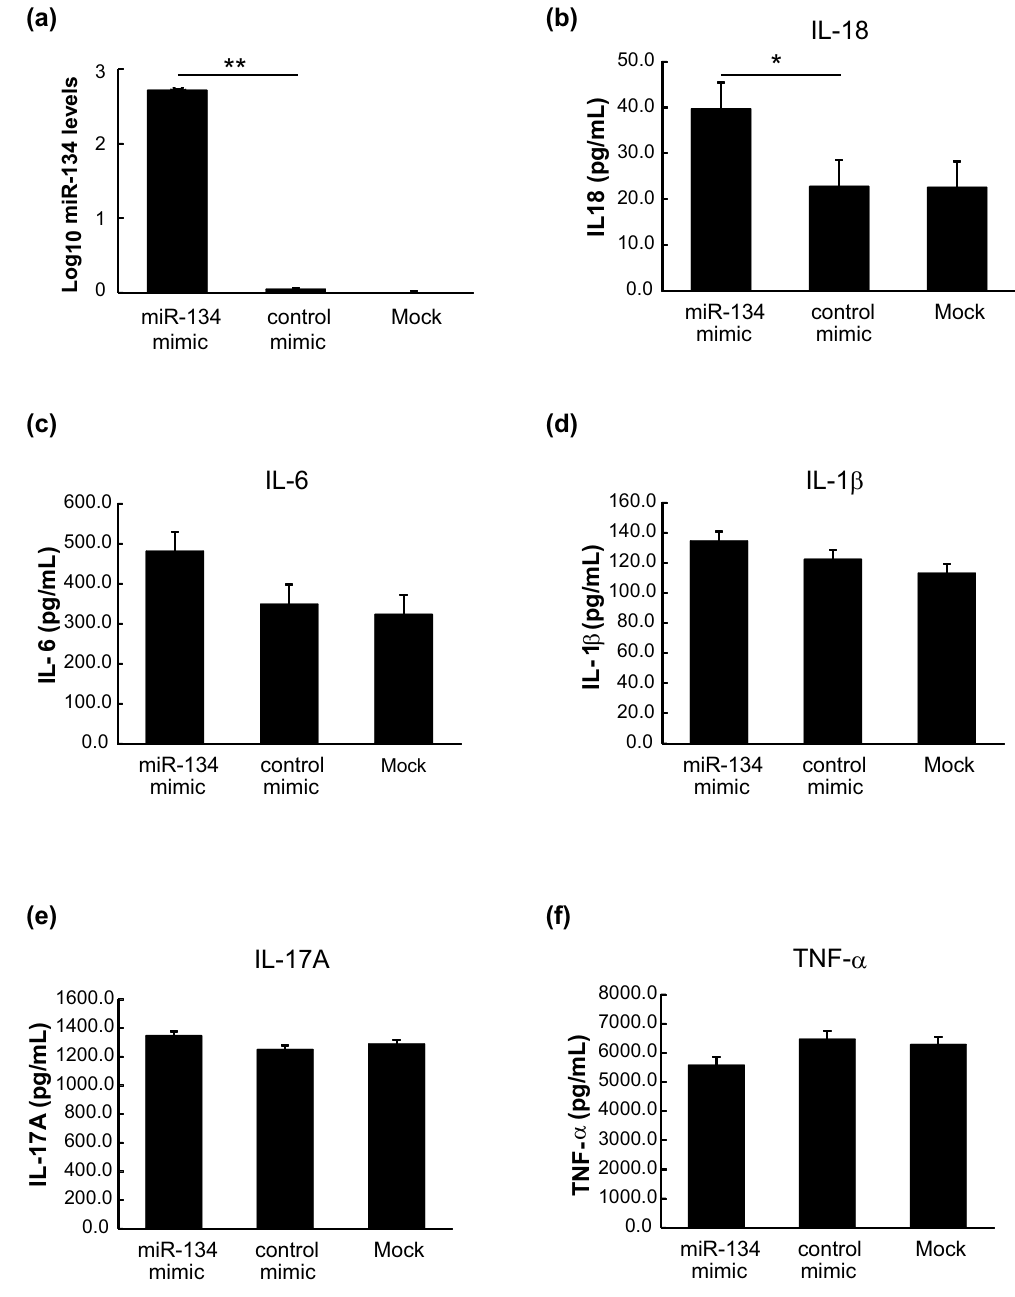
Figure 2. A close link of microRNA-134 (miR-134) expression with levels of IL-18. ( a ) Comparison of miR-134 expression levels in miR-134 mimic-transfected cells, in control-transfected cells, or in non-transfection cells (mock). Comparison of supernatant levels of proinflammatory cytokines including ( b ) IL-18, ( c ) IL-6, ( d ) IL- 1 β , ( e ) IL-17A, and ( f ) TNF- α released in miR-134 mimic-expressing cells, in mimic control-expressing, and in non-transfection cells (mock) after 24 hours of transfection. Data are presented as mean ± SEM. * P < 0.05, versus mimic control-expressing or in non-transfection cells, determined by the ANOVA test with Scheffe